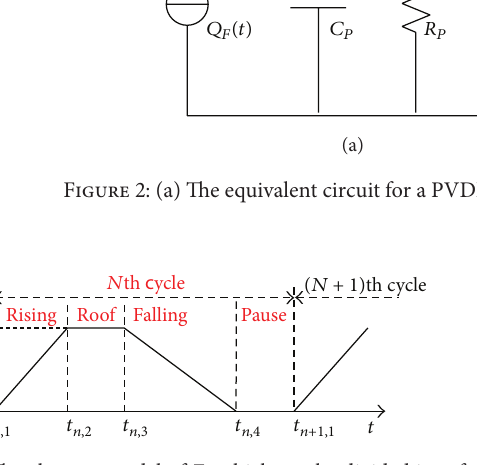
Figure 3: The abstract model of 𝐹 1 which can be divided into four stages during one cycle.